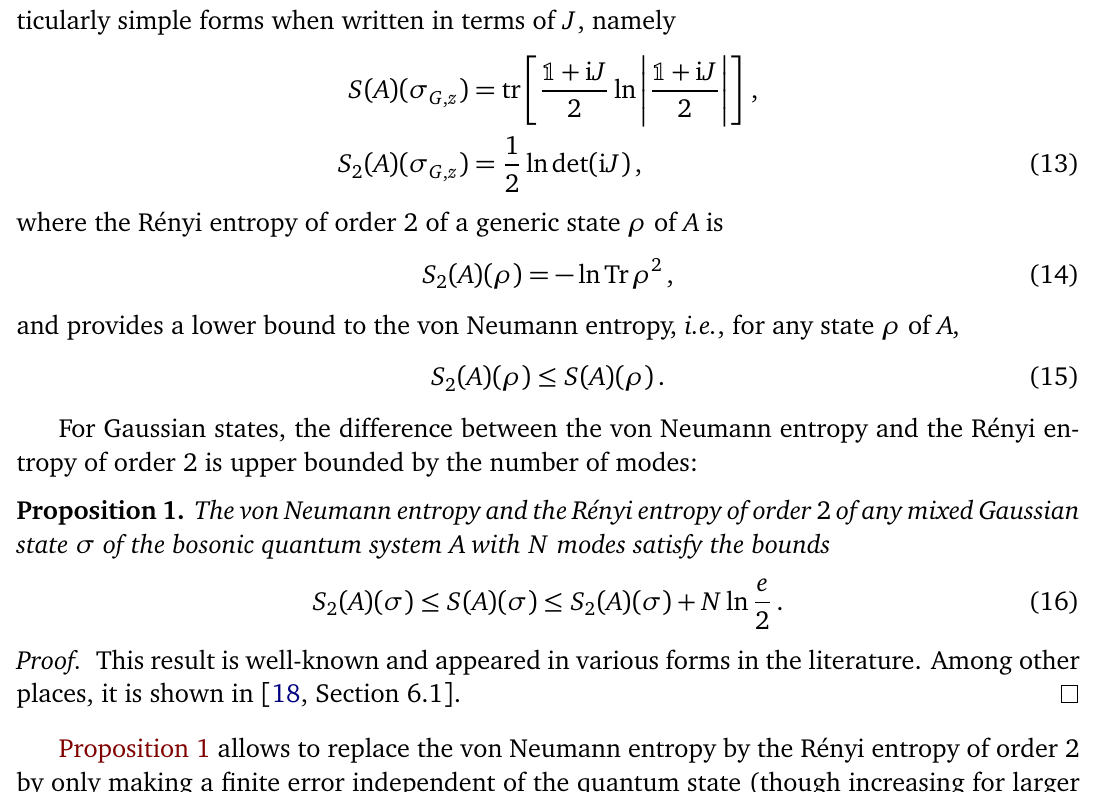
in a system A is G ( A ) and from above by the asymptotic 2